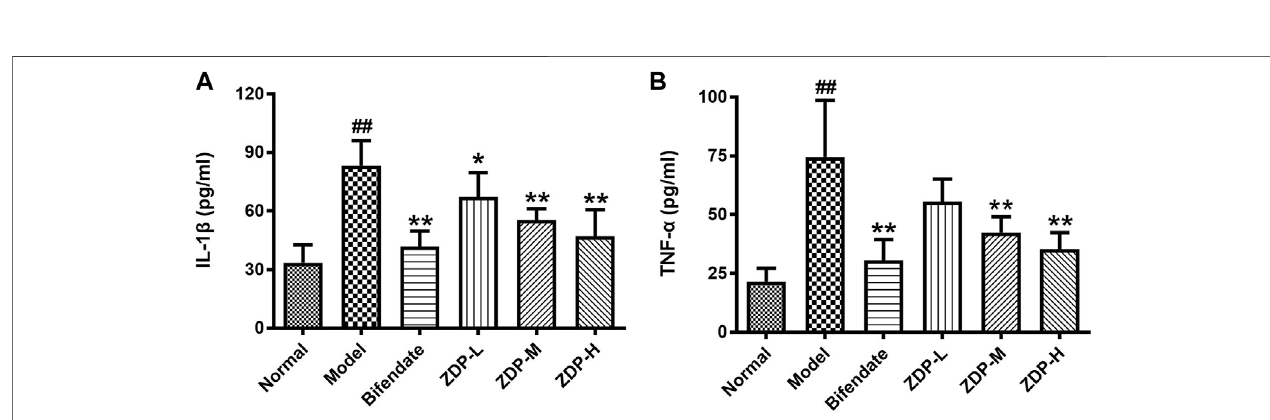
FIGURE 6 | ZDP decreases the level of liver IL-1 β and TNF- α in the murine model of ALI induced by CCl 4 . IL-1 β (A) and TNF- α (B) levels were measured in mouse hepatic tissue samples (Normal control, Model control, Bifendate-treated control, ZDP-L, ZDP-M and ZDP-H) by ELISA. Data from six to eight mice per group are expressed asthemean ± SD. Statisticalanalysis: ## p < 0.01compared withthenormalgroup;* p < 0.05, ** p < 0.01compared withthemodelgroup, One-Way ANOVA.